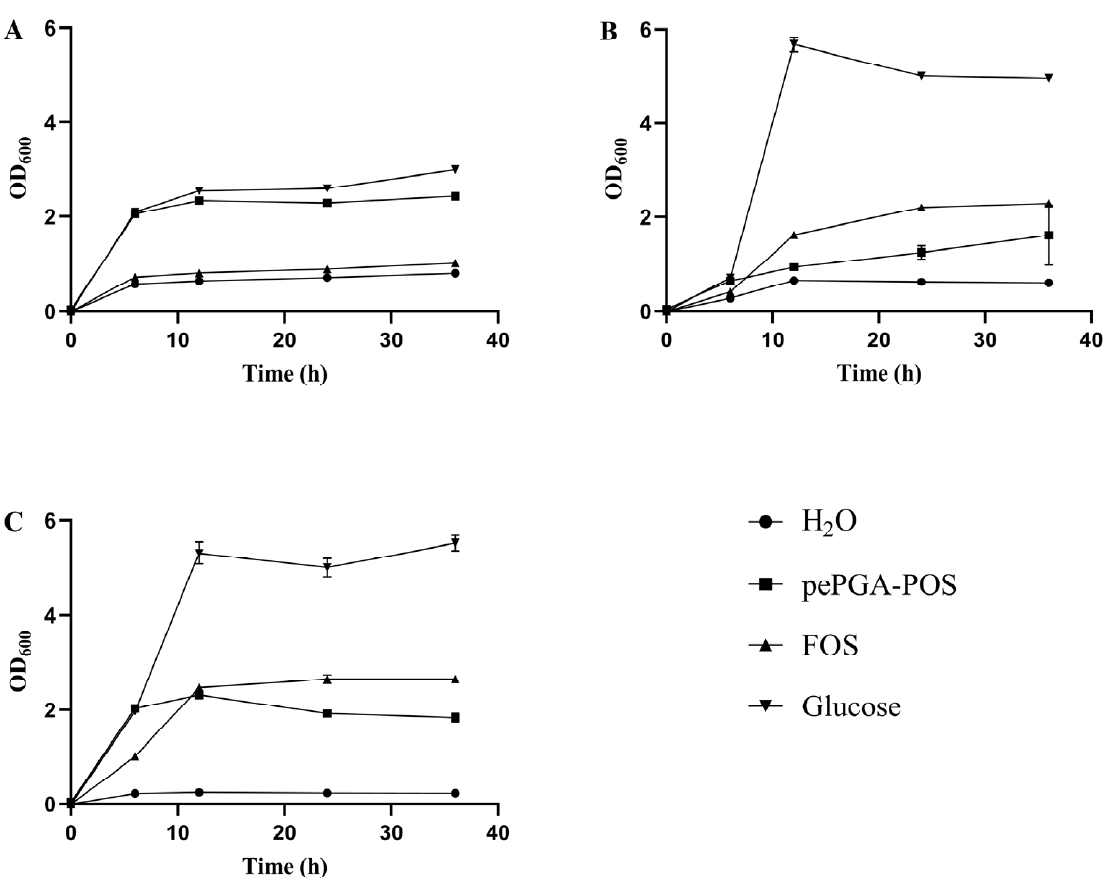
Figure 5. Growth curve of ( A ) P. acidilactici , ( B ) L. paracasei , ( C ) L. plantarum in different carbon sources or no carbon source.